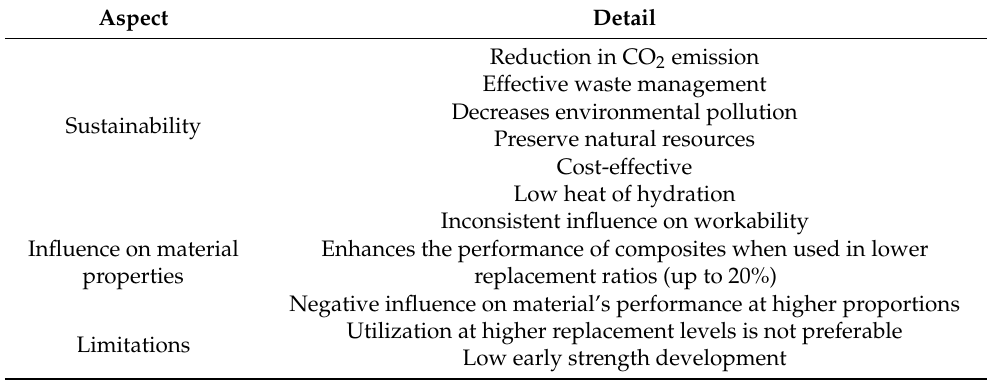
Table 5. Comparison of various aspects of utilizing silica fume and fly ash in cementitious materials.